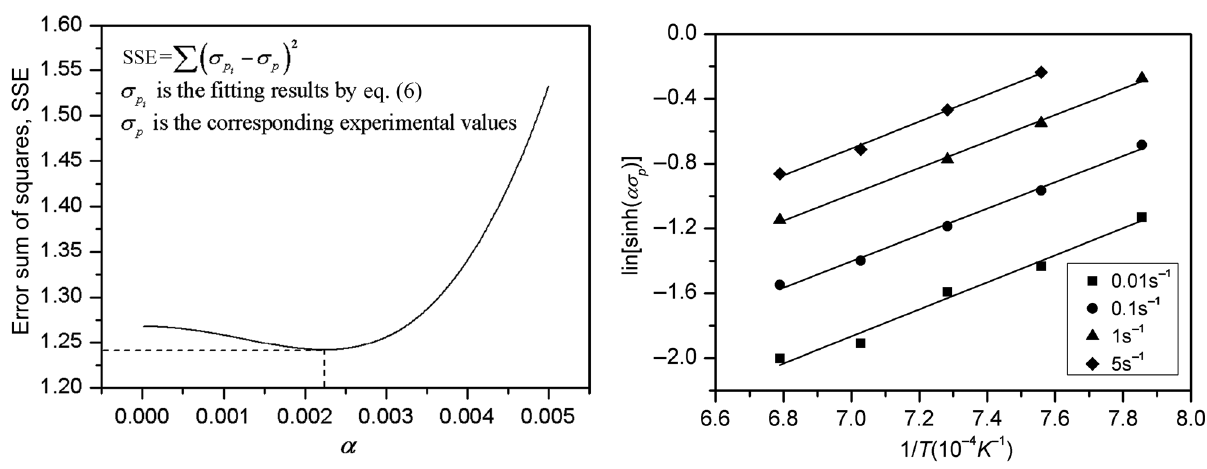
According to the linear relationships between ln[sinh( ασ p )] and 1/ T at different strain rates shown in Figure 5, the average value of the slope is 8,232.510. Then, the average value of Q is determined as 367.3 kJ/mol.